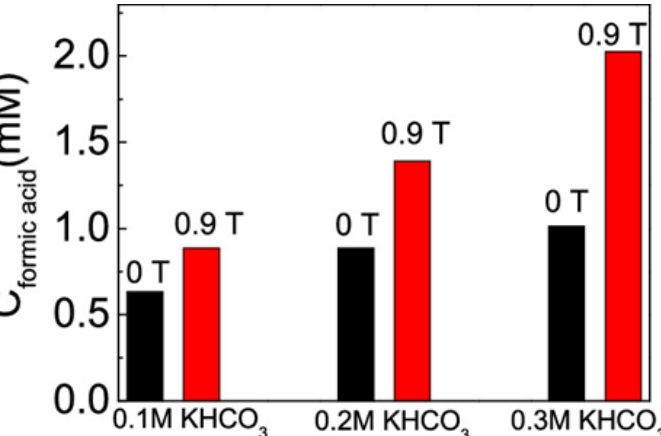
Figure 16. Magnetic field-dependent enhancement of formate yield ( − 1.7 V (vs/ Ag/AgCl)) with the same applied electrode potential for different concentrations of KHCO 3 electrolytes. Reprinted with permission from [114]. Copyright (2020), with permission from the American Chemical Society.